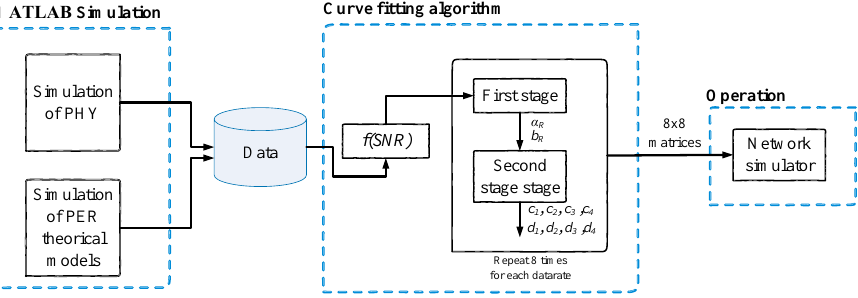
Figure 1. Operation mode of the